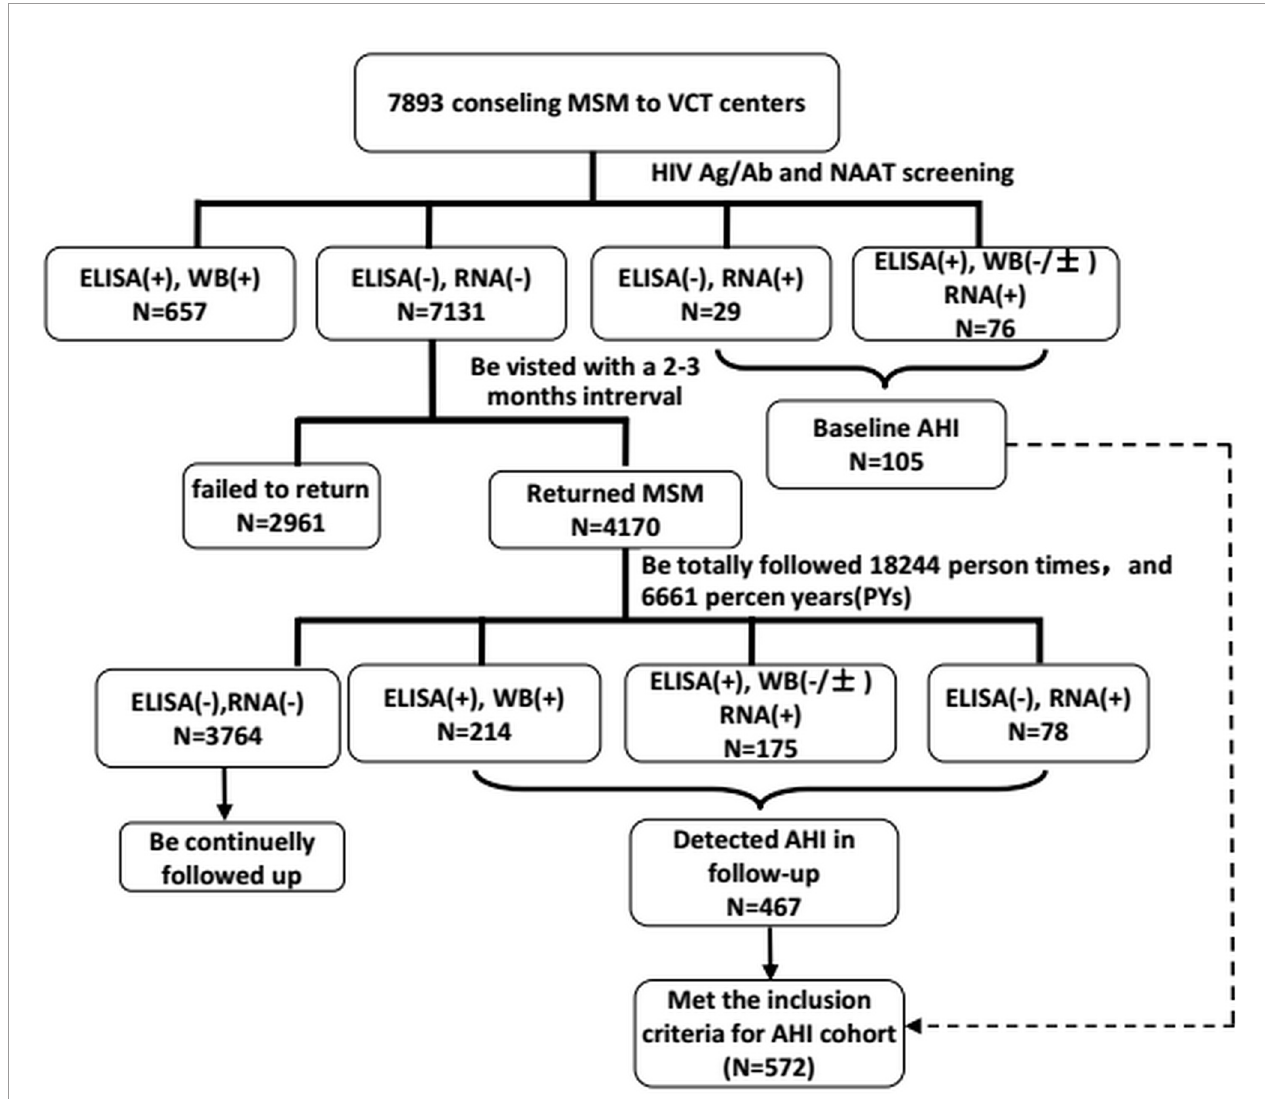
FIGURE 1 | The fl ow chart of establishment of acute HIV infection cohort., 4170 subjects were followed 6661 person yeras (PYs) and be detected 467 HIV sereconverters, the HIV incidence rate HIV incidence density were 11.20%(95%CI, 10.26-12.20) and 7.01(95%CI, 6.41-7.65),